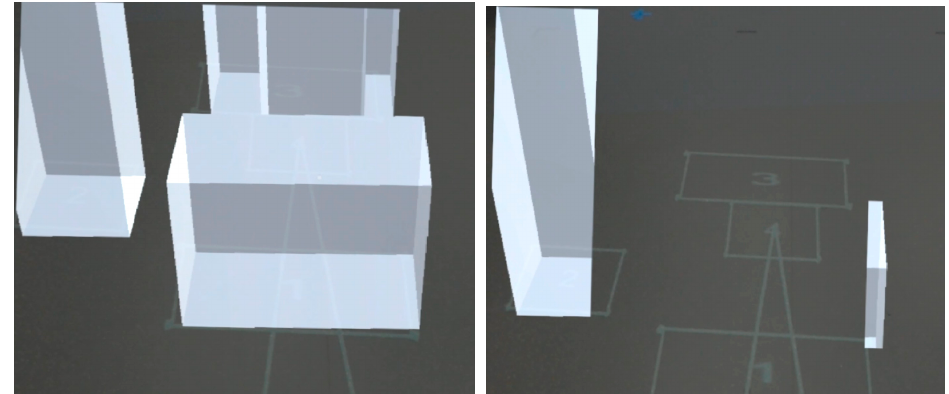
Figure 14. Tramlines converging on the middle of object four which the user is focused on in the HMD, showing unfiltered ( left ) and filtered ( right ) views using the cutout technique to mask augmentations in the vertical region in the middle of the user’s FOV.